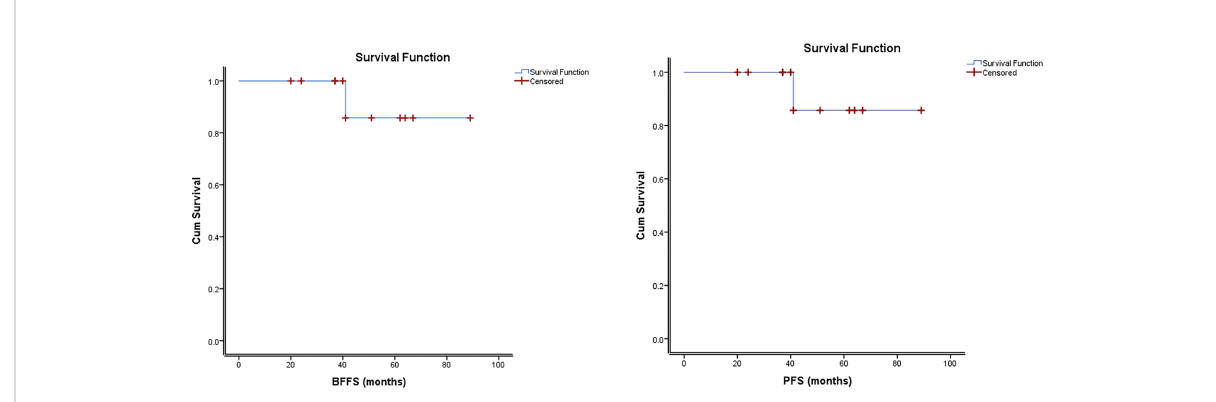
FIGURE 3 Kaplan Meier Estimates of Biochemical Failure-Free Survival and Progression – Free Survival.